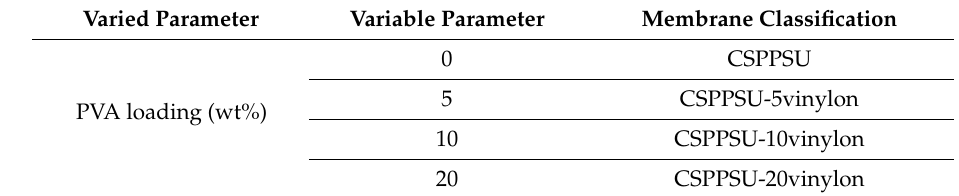
1. Classification of crosslinked sulfonated polyphenylsulfone-vinylon (CSPPSU-vinylon) membranes. Varied Parameter Variable Parameter Membrane Classification 0 CSPPSU 5 CSPPSU-5vinylon PVA loading (wt%) 10 CSPPSU-10vinylon 20